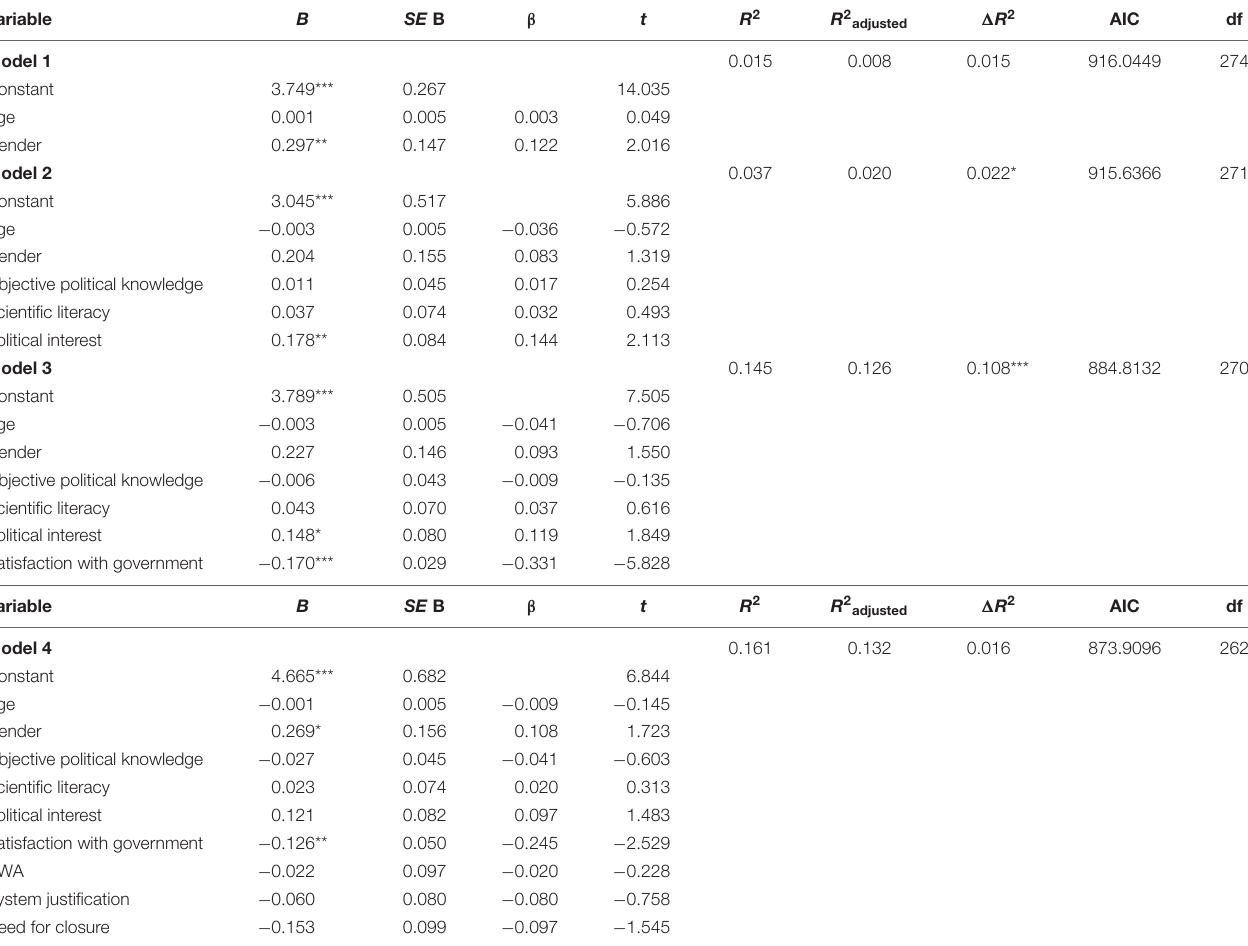
TABLE 4 | Hierarchical regression results for belief in anti-government real